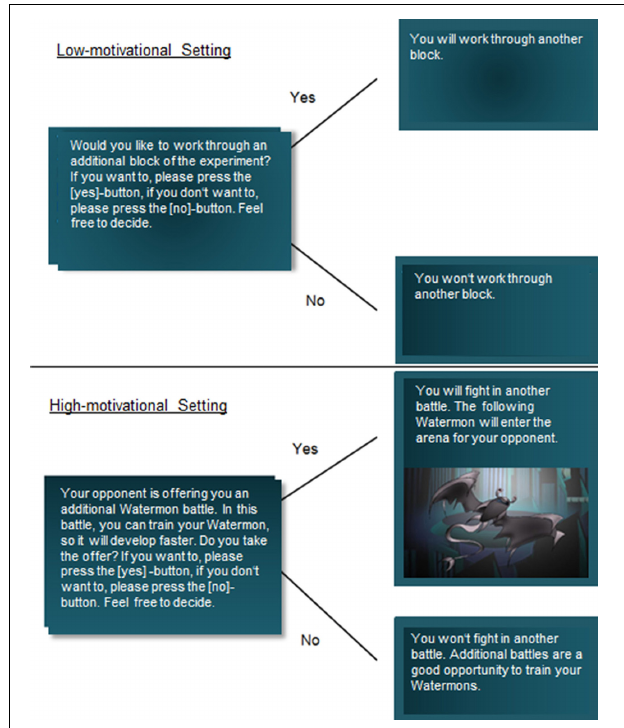
FIGURE 4 | Different selection windows in respect of the willingness decisions in the low-motivational (upper area) and the high-motivational condition (lower